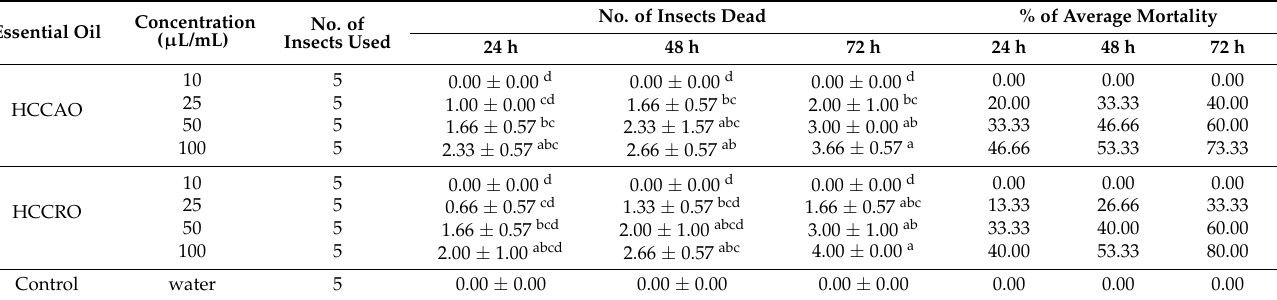
Table 6. Mortality percentage of S. litura insect treated with HCCRO and HCCAO.